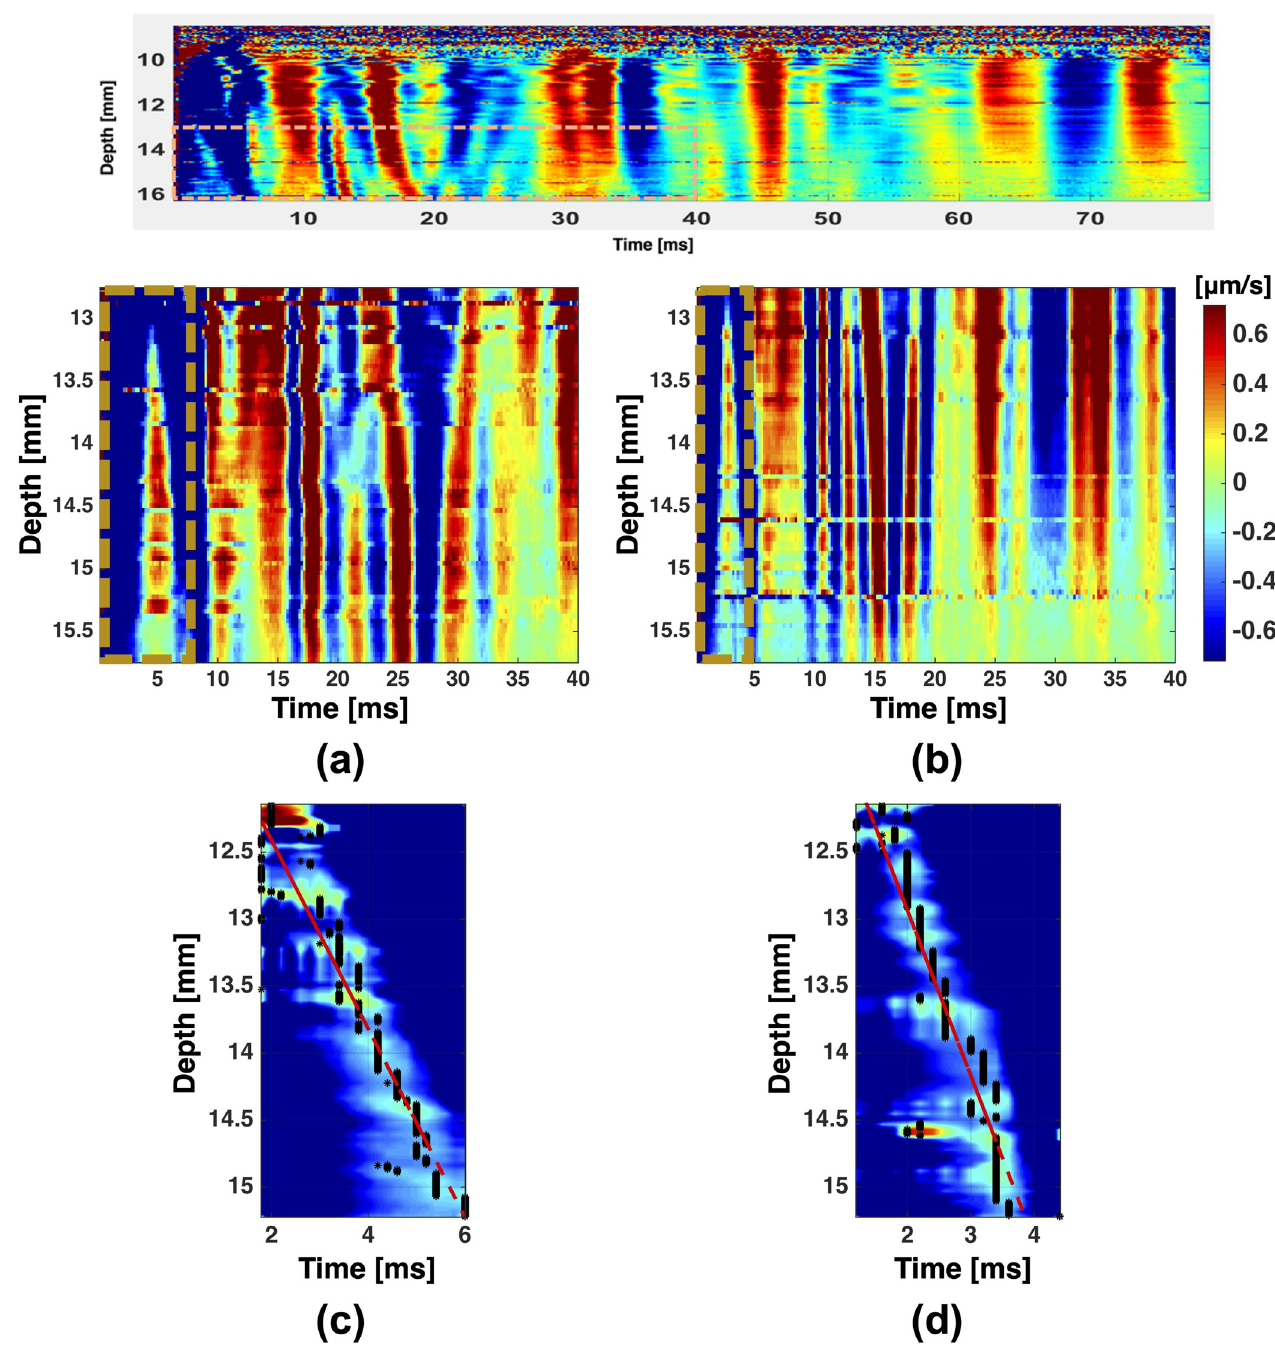
Fig 3. The arrival-time plots cropped around the ultrasound focus for (a) 0.3% agarose and (b) 0.4% agarose homogeneous phantoms. (c) and (d) Directionally filtered axial displacement fields within the brown dashed rectangles indicated on (a) and (b), respectively. The false-color scale indicates the shear wave speed